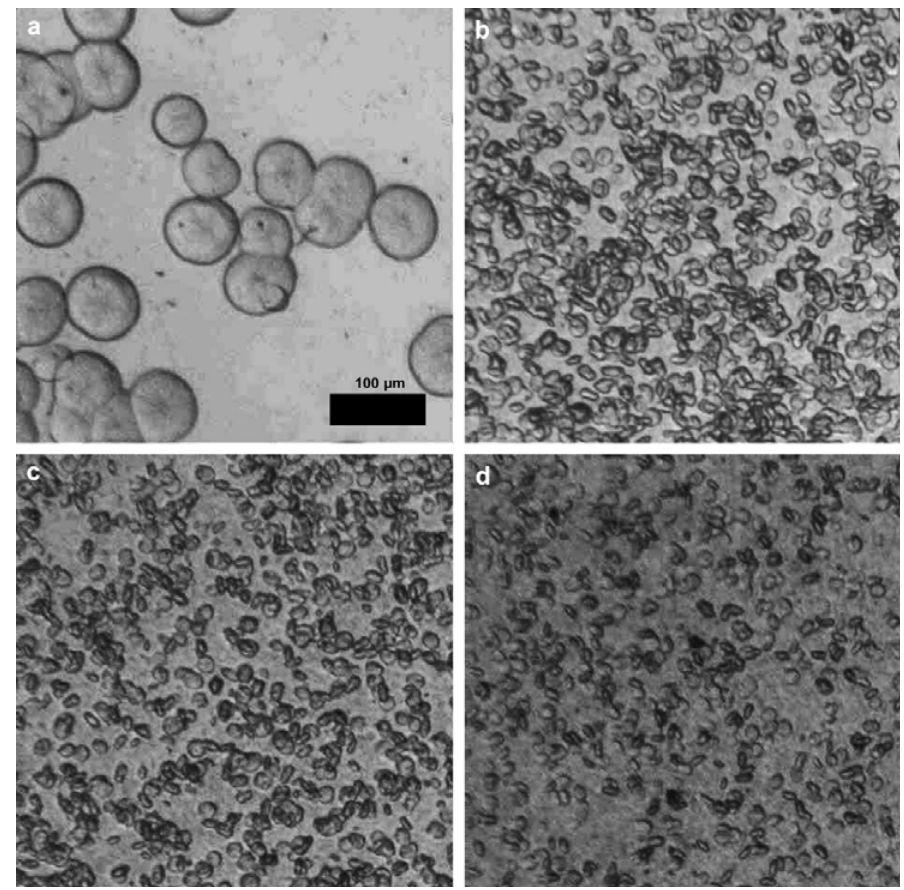
Figure 18. Optical micrographs of iPP/CNTs with CNTs concentrations of a) 0 wt %, b) 0.2 wt %, c) 0.5 wt % and d) 1.0 wt %, during isothermal crystallization at 136 °C for 21 min, 6 min, 6 min, and 6 min, respectively. Optical micrographs were taken in bright field. Reproduced with permission from ref.